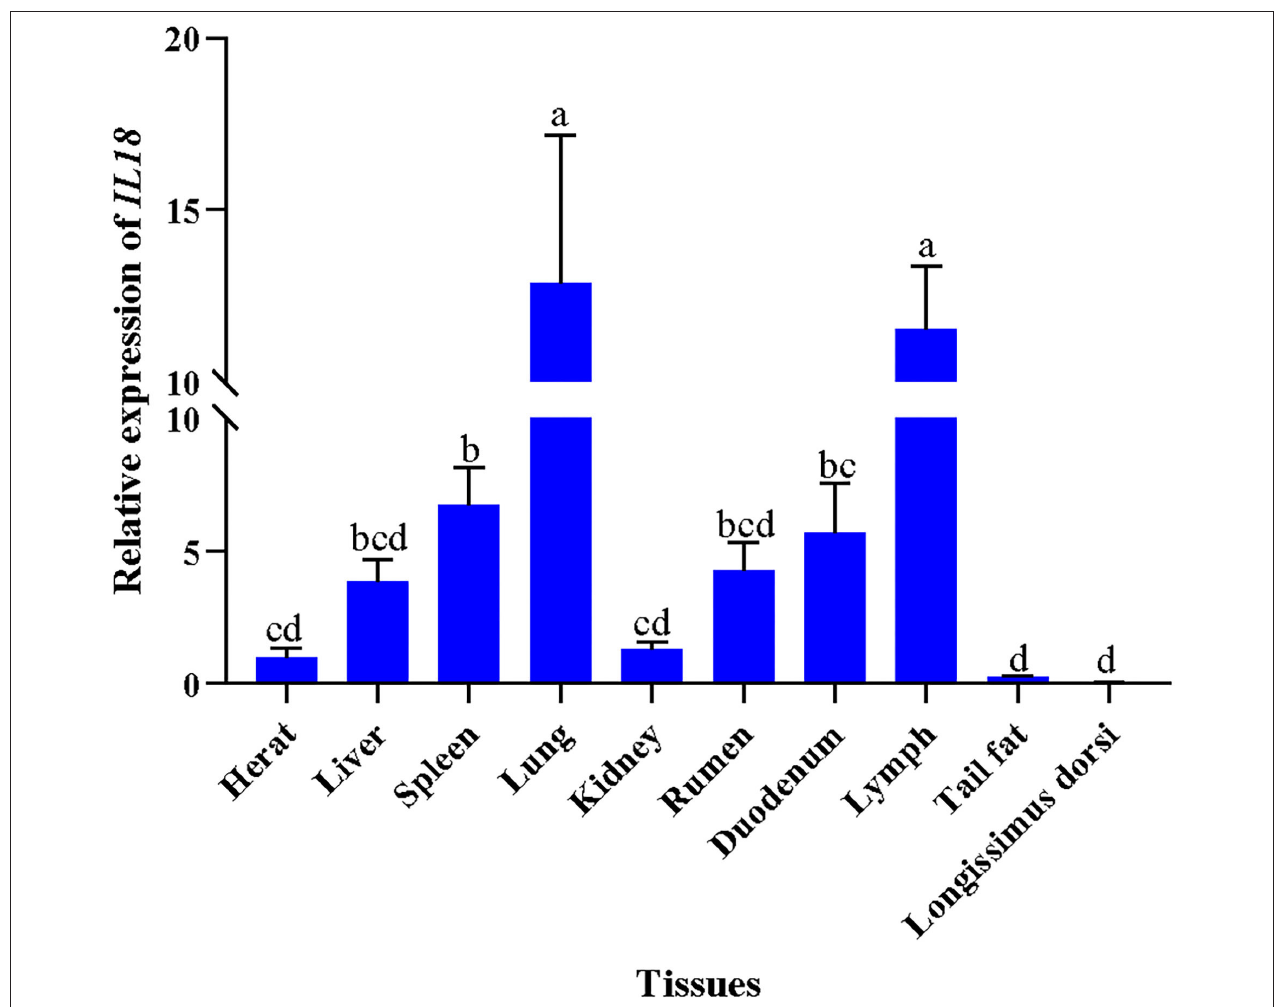
FIGURE 3 | The expression levels of IL18 gene in 10 tissues of the Hu sheep. Different letters indicate significant difference ( p <